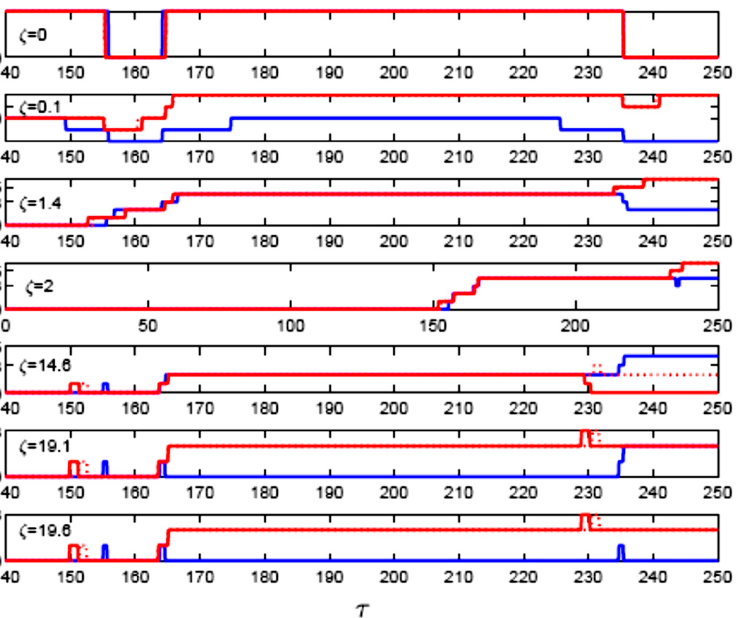
Figure 8. The drive pulses’ relative phase with various prolonged spaces and expressed in π units. The initial pulse profiles are depicted in Figure 2.